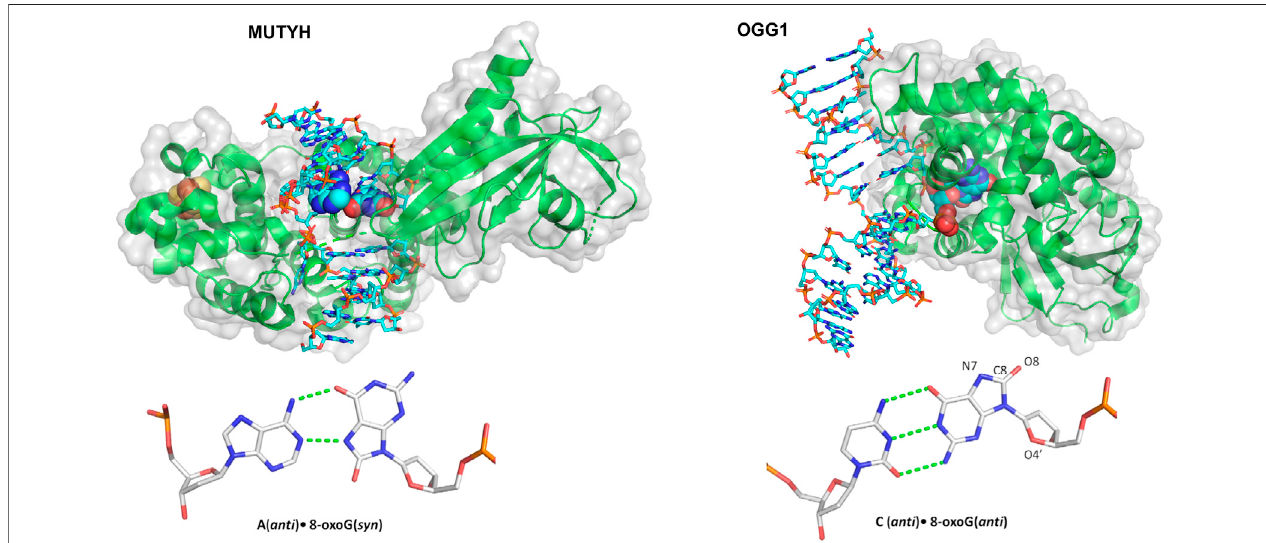
FIGURE8| Structuresoftwomammalianglycosylasesboundtotheirdamagedsubstrates. (Left) CrystalstructureofMUTYH(greenribbons)boundtoDNA(cyan sticks), containing the oxidative damage substrate A:8-oxoG (displayed as spheres). Its Iron-sulfur cluster is displayed as orange and yellow spheres. Structure taken from PDB ID: 4YPH. (Right) OGG1 crystal structure (green ribbons) bound to a damaged DNA (cyan sticks) substrate containing a C:8-oxoG base pair (spheres). Structure taken from PDB